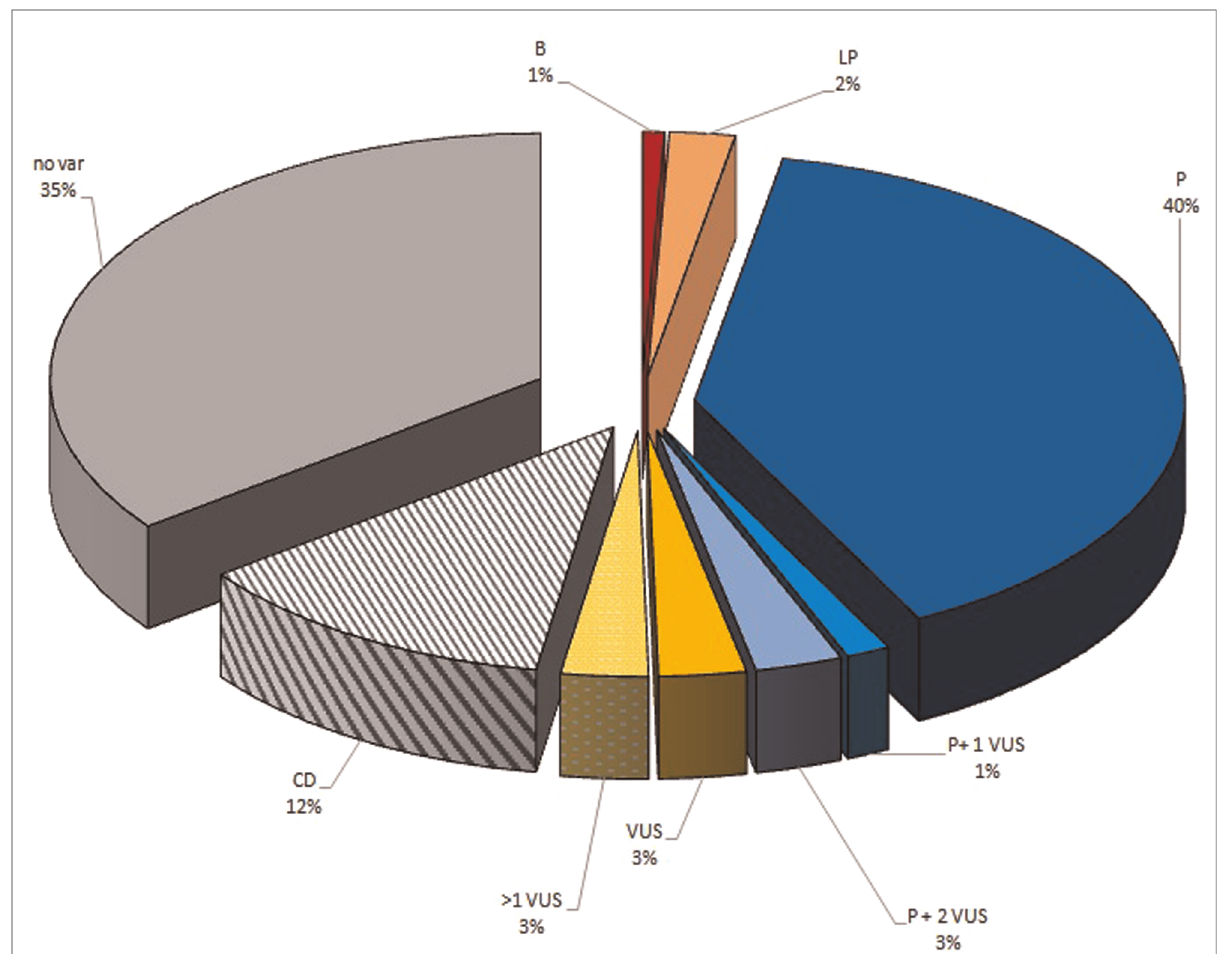
FIGURE 1 Graphical representation of IT genetic variants detected on the CHIPS cohort. B, benign variant; LP, likely pathogenetic variant; PV, pathogenetic variant; VUS, variant of uncertain signi fi cance; CD, clinical diagnosis based on clinical features or family history; no var, no candidate variants identi fi